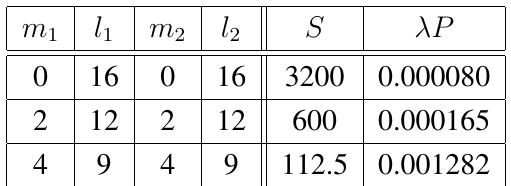
Table 2. S and (cid:21)P